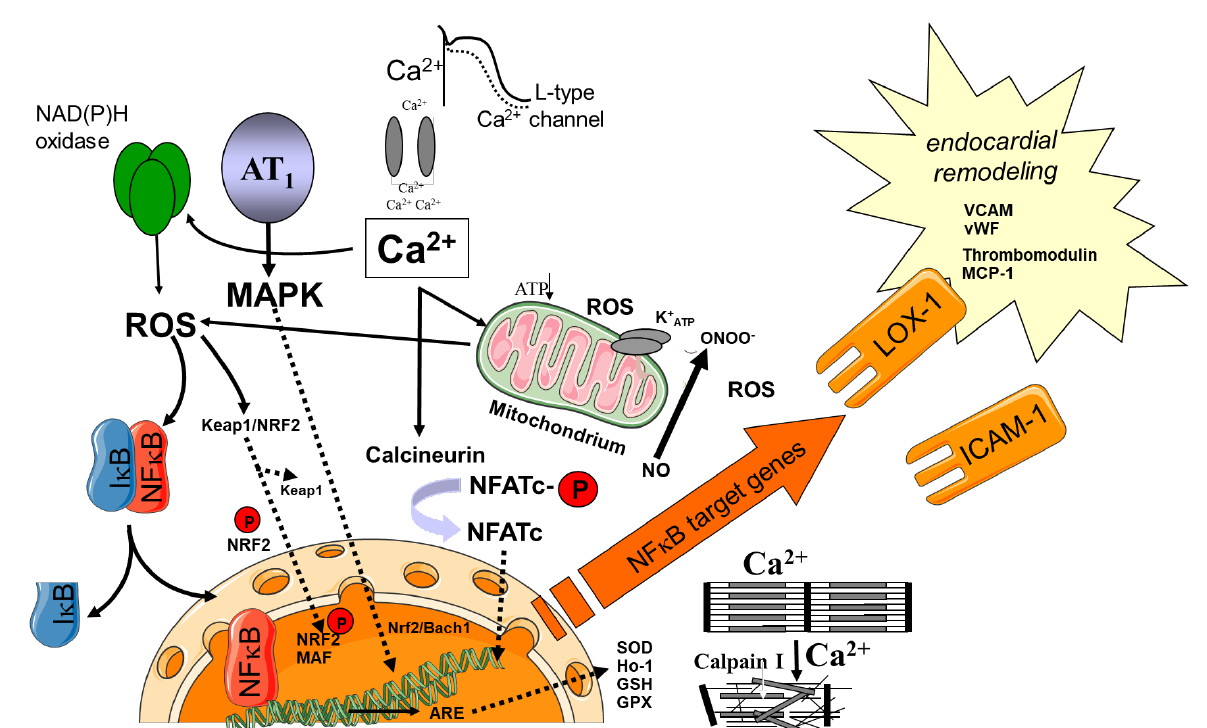
Figure 1. Association between atrial fibrillation (AF) with cellular calcium overload, shortening of the action potential, oxidative stress (reactive oxygen species; ROS) and activation/expression of several pathways and genes, which interfere with cellular morphology/function and atrial thrombogenesis. Angiotensin II can modify several effects through activation of the AT1 receptor. Activation of different Mitogen activated kinases (MAP kinases) induce several cellular effects including cellular hypertrophy. In addition, calcium-activated phosphatases (calcineurin) and protease (calpain I) induce structural cellular changes. Oxidative stress is counterbalanced to some extent by activation of the antioxidant response element (ARE) and generation of superoxide dismutase (SOD), glutathione (GSH), glutathione peroxidase (GPX). NRF2 = nuclear factor-erythroid-2-related factor, Keap1 = Kelch-like ECH-associated protein 1.